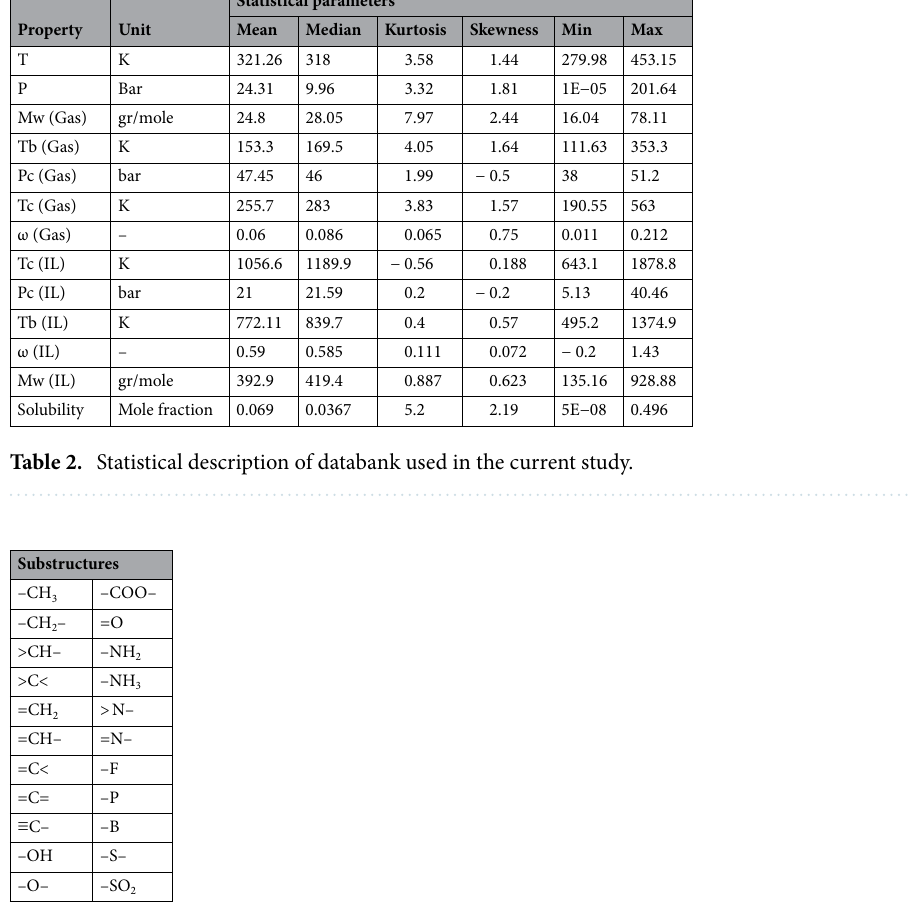
Table 3. Different substructures of ionic liquids and